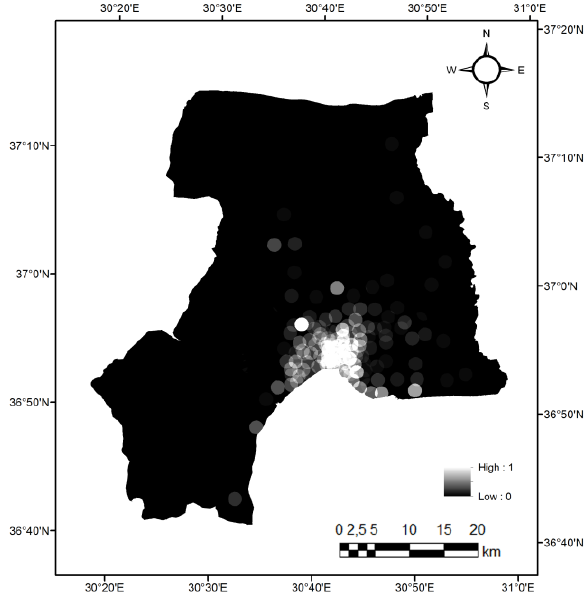
Figure 11. Population